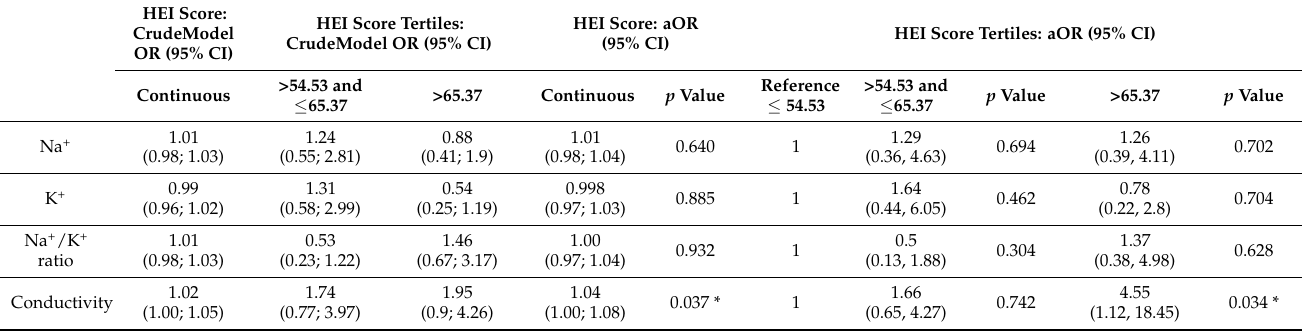
Table 2. Analysis of the association between diet quality with sodium, potassium, and